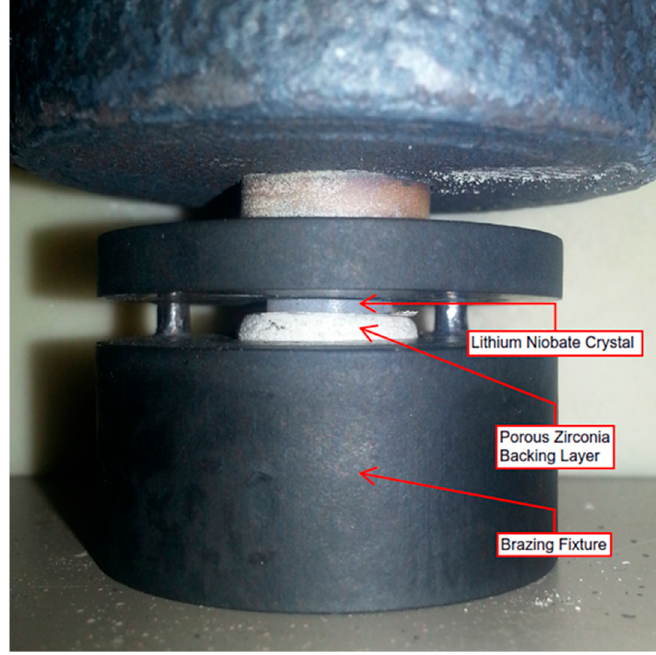
Figure 1. Fixture used during brazing process.